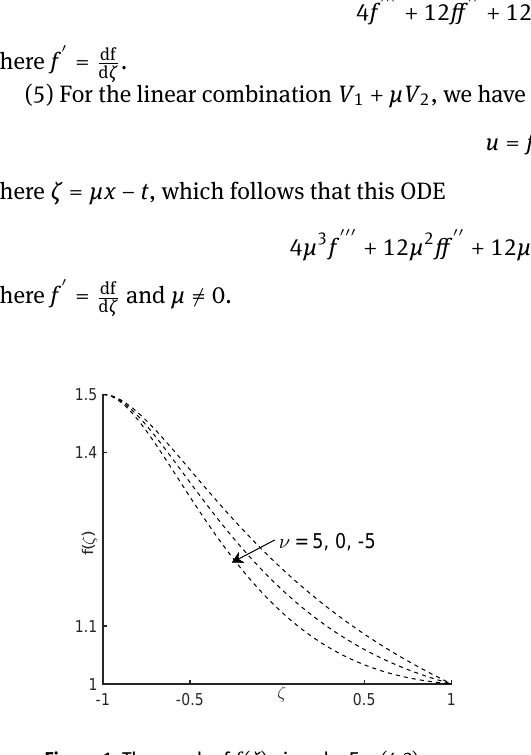
Figure 2: The graph of f ( ζ ) given by Eq. (4.4) .